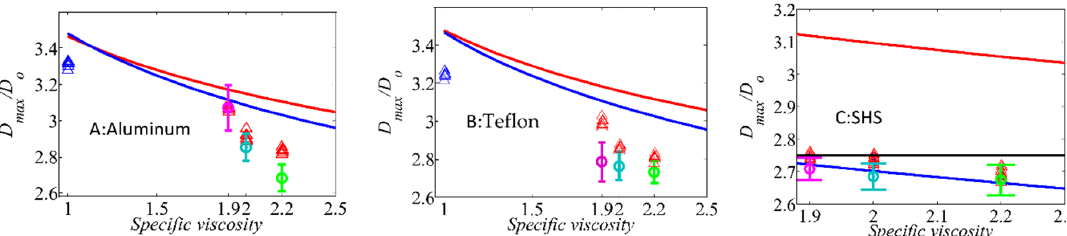
Figure 7. Comparison of maximum spreading diameter with energy based model (blue line), hydrodynamic analytical model (red line) for aluminum ( A ) and Teflon ( B ) substrates along with scaling law analysis (black line) only for SHS ( C ). Room temperature water droplet and water ‐ glycerol solution with same viscosity of supercooled water droplet aree represented by blue and red triangles, respectively. Supercooled waters are illustrated with error bars. Blue triangle, pink, sky blue, and green represent droplet at room temperature, − 2 °C, − 3.5 °C and − 5.5 °C, respectively.